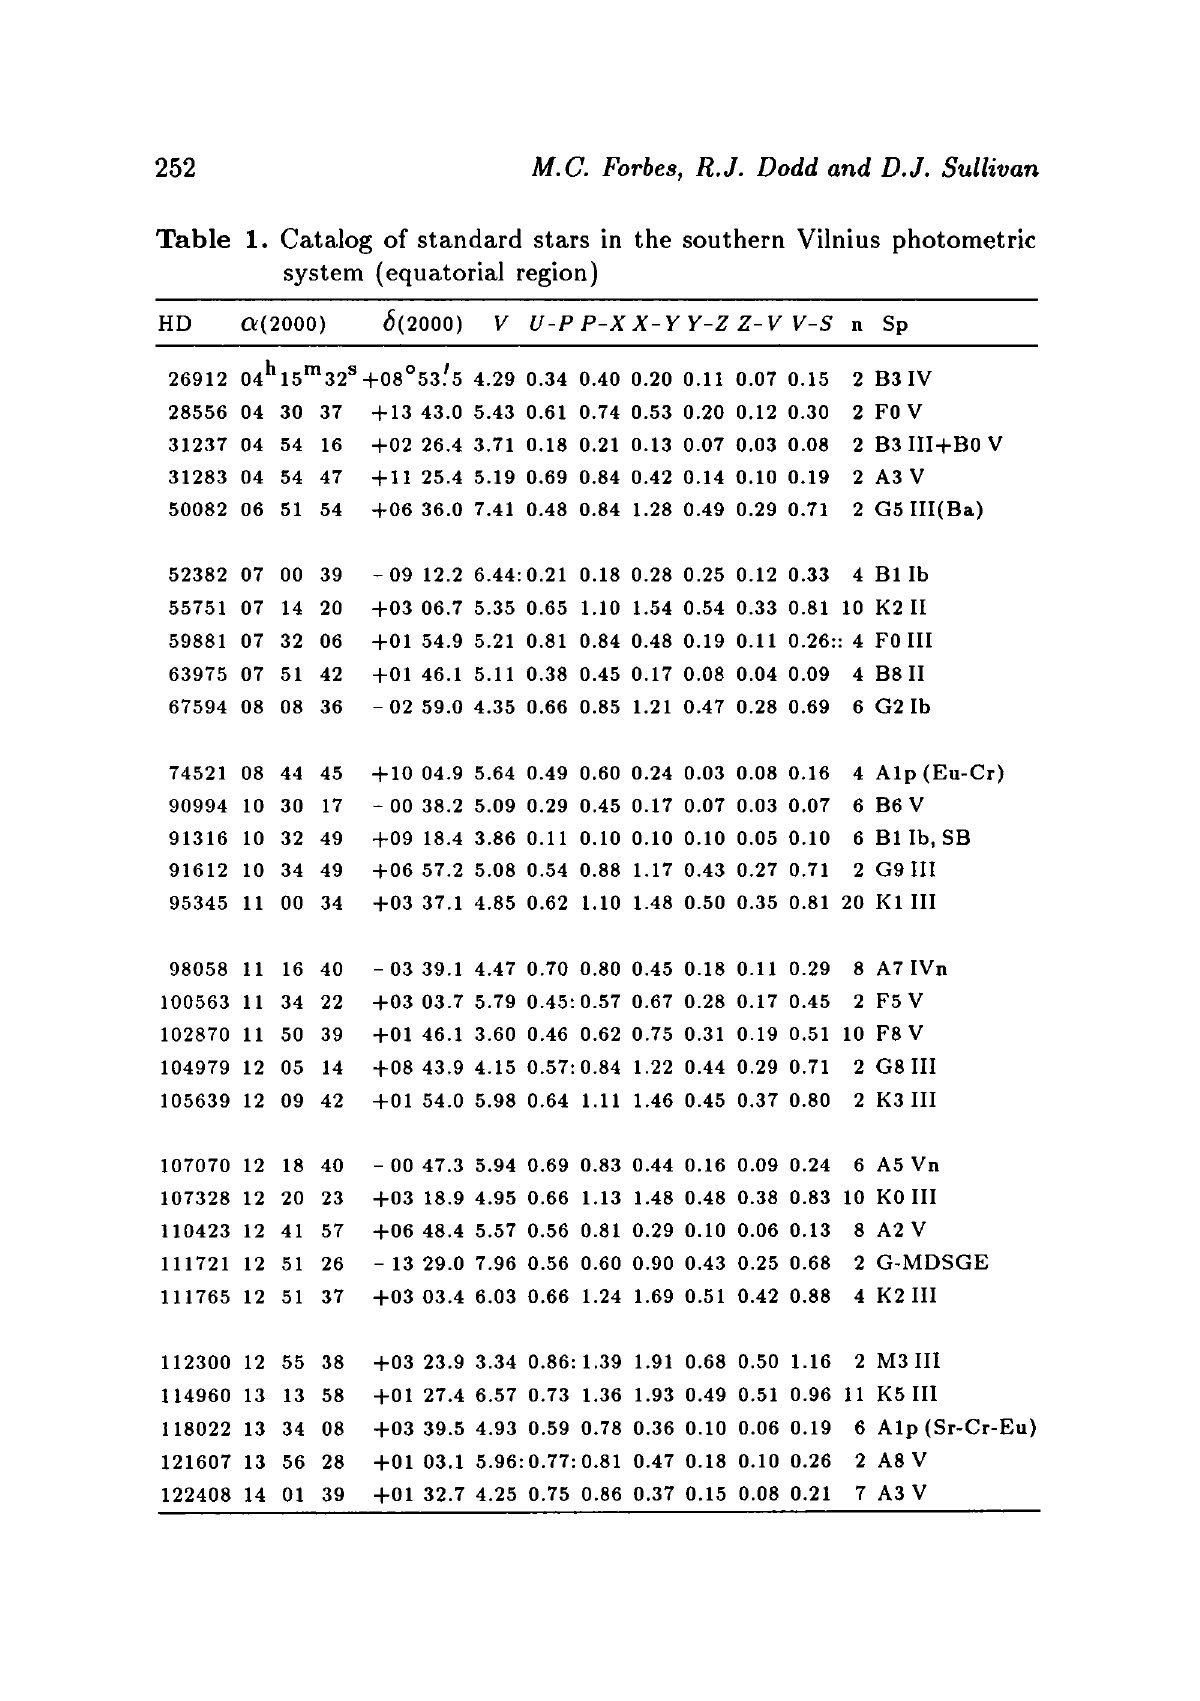
Table 1. Catalog of standard stars in the southern Vilnius photometric system (equatorial